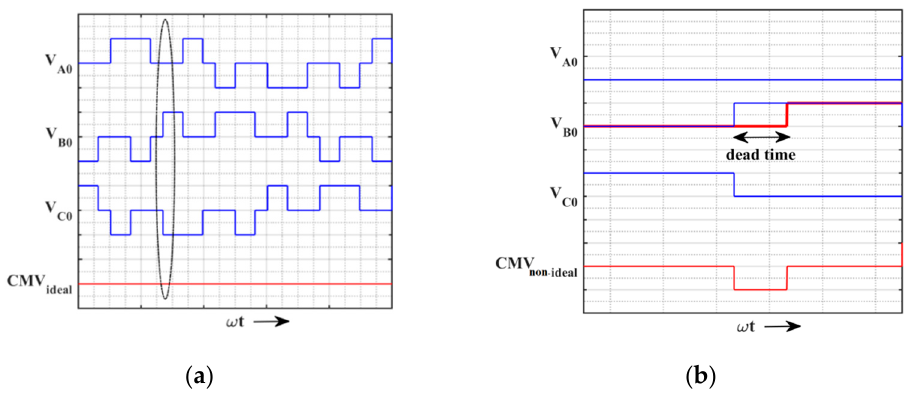
Figure 9. CMV mitigation: ( a ) The CMV in ideal condition [2]; ( b ) the CMV in real condition (needs compensation).